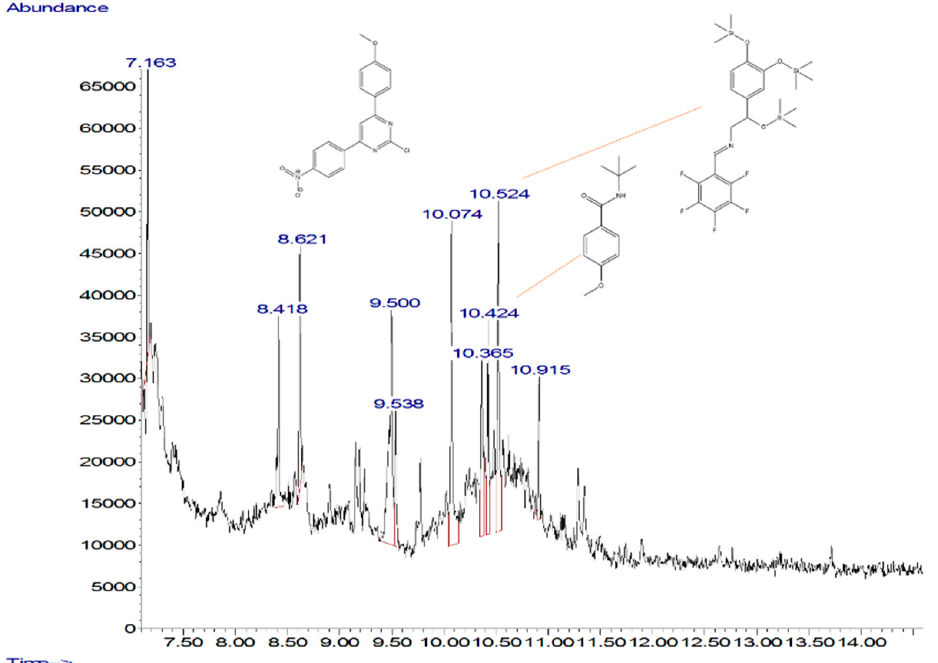
Figure A4. GC-MS chromatogram from MAW–SCG.